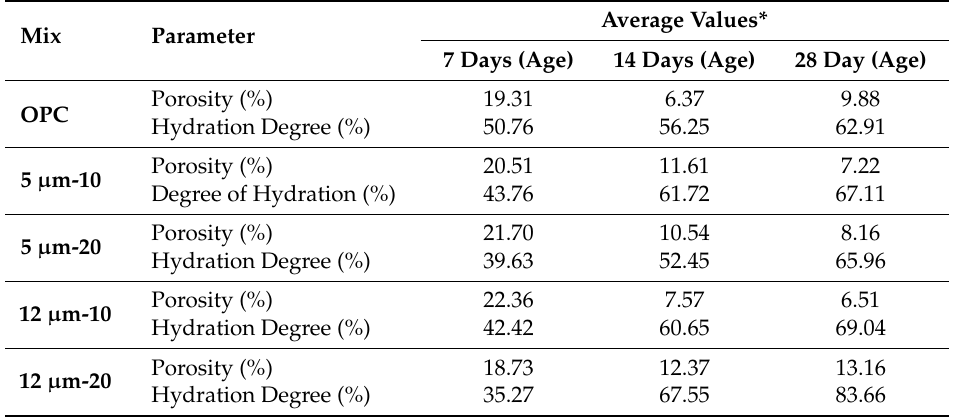
Table 3. Parameters obtained from BSE image analysis for cement pastes at various ages (* the values indicate the average of porosity and hydration degree calculated from various frames in BSE